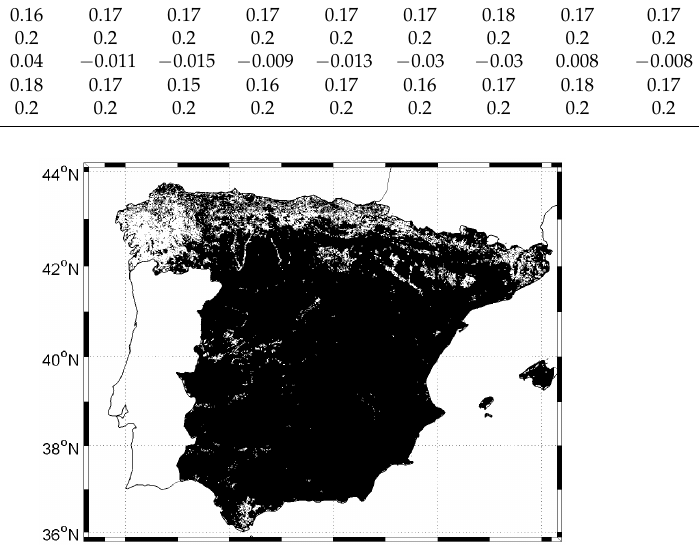
Figure 5. The model underestimates the annual GPP in the lighter peixls when using NDVI.